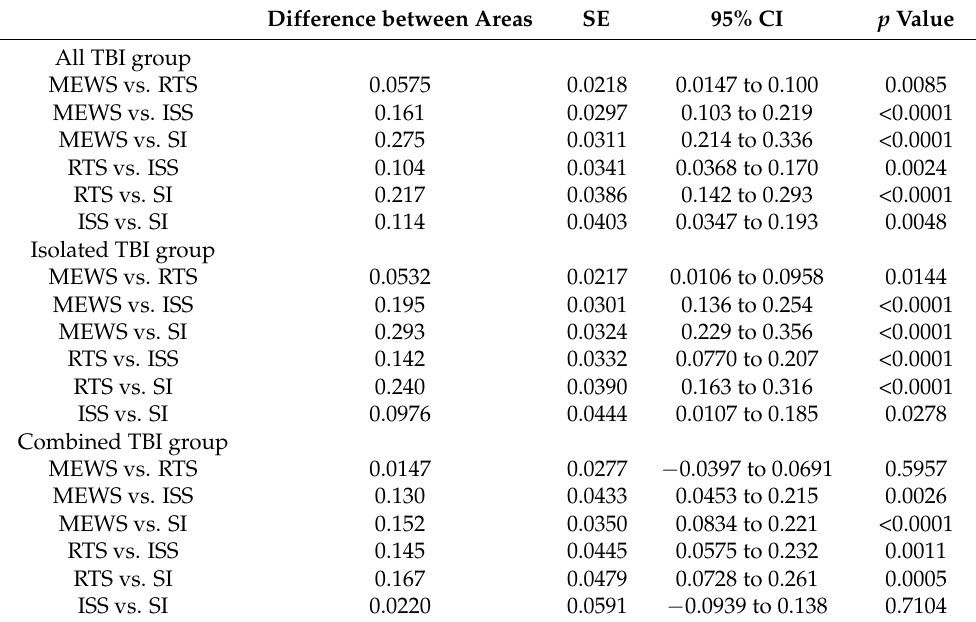
Table 5. Pairwise comparison test of the ROC curves including MEWS, RTS, ISS, and SI for in-hospital mortality in TBI patients. Difference between Areas SE 95% CI p